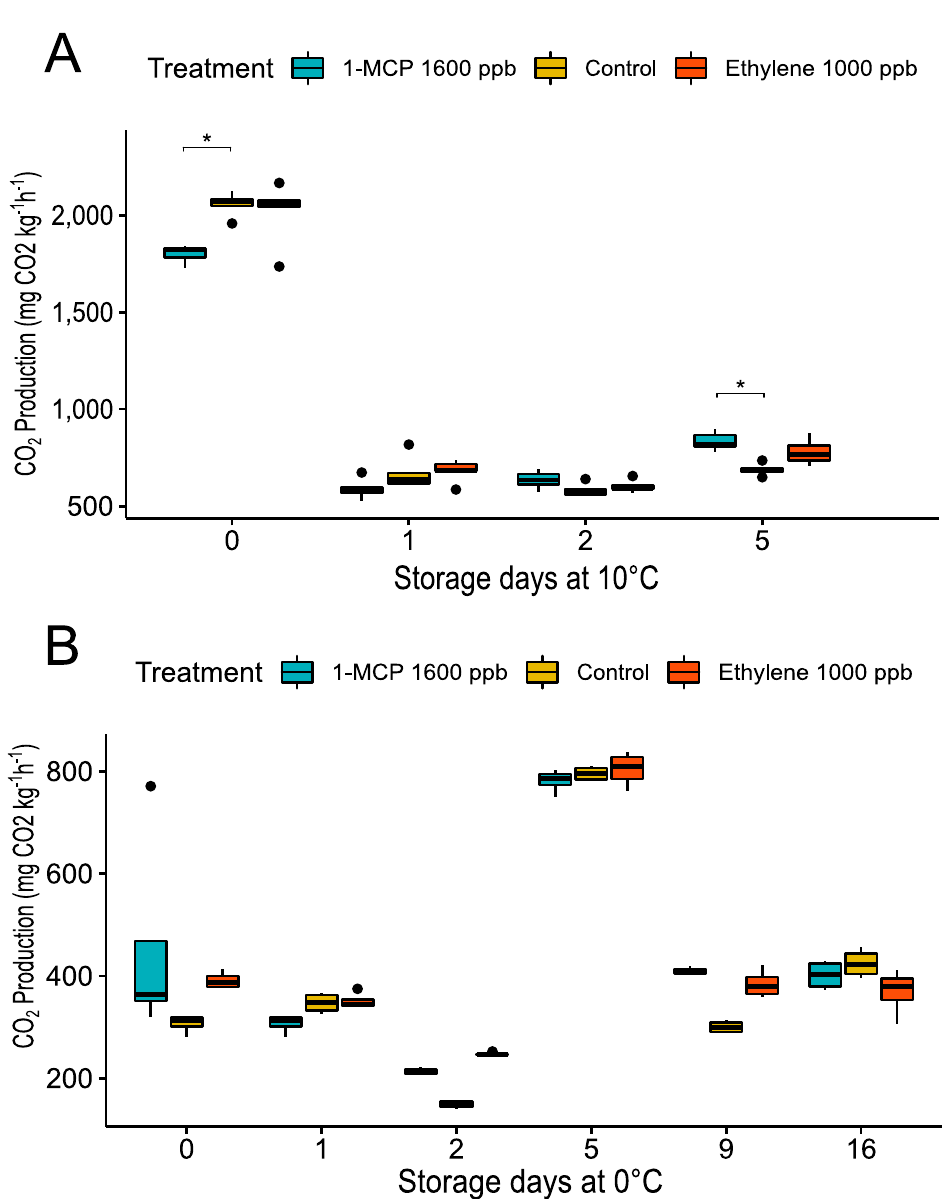
Figure 7. CO 2 production of raspberry ( Rubus idaeus ‘Heritage’) fruit during treatment with ethylene and 1-methyl cyclopropane (1-MCP). The storage assay was performed at the W stage of raspberry and stored for 5 and 16 days at 10 ◦ C ( A ) and 0 ◦ C ( B ), respectively. CO 2 production (mg CO 2 kg − 1 h − 1 ) was determined for ethylene and 1-MCP-treated fruits and controls. Data represent the means ± S.D. from five sample units (each containing ten fruits). Asterisks indicate significant differences between treatments at the same storage time ( p ≤ 0.05). Boxplots show each group’s distribution (treatment) and the black line (central value in the box) signs the median value. Points out of the boxplots show outlier